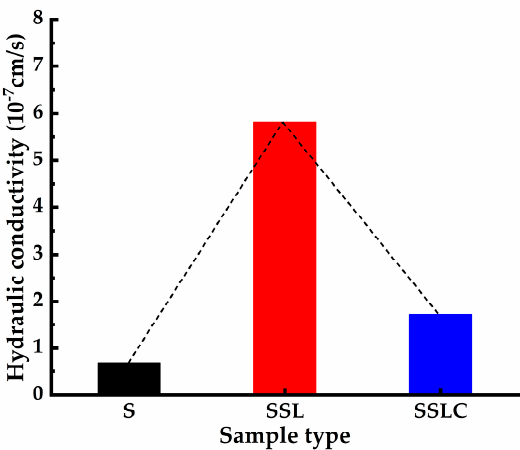
Figure 13. The permeability test results of the test